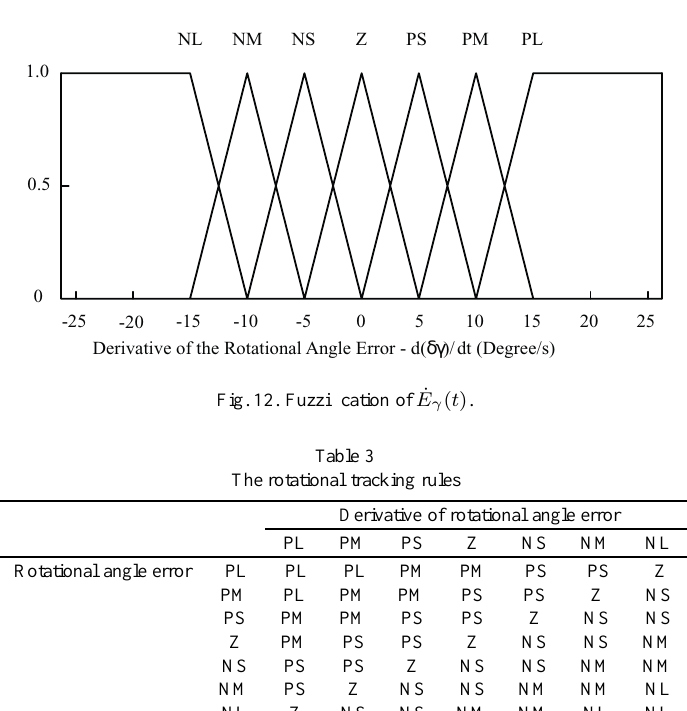
Fig. 11. Fuzzification of E γ ( t ) .